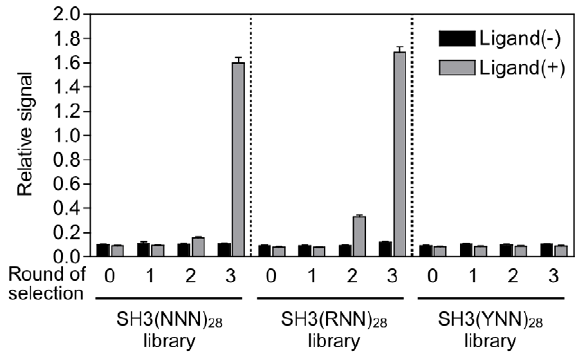
Figure 4. Fraction of functional SH3 sequences at each round of selection. The total amount of three kinds of libraries, SH3(NNN) 28 , SH3(RNN) 28 and SH3(YNN) 28 , that bound to the peptide ligand before (0) and after 1–3 rounds of selection were quantified by ELISA (gray bars). Black bars show negative controls (no ligand peptide was immobilized). Error bars indicate s.d. of four